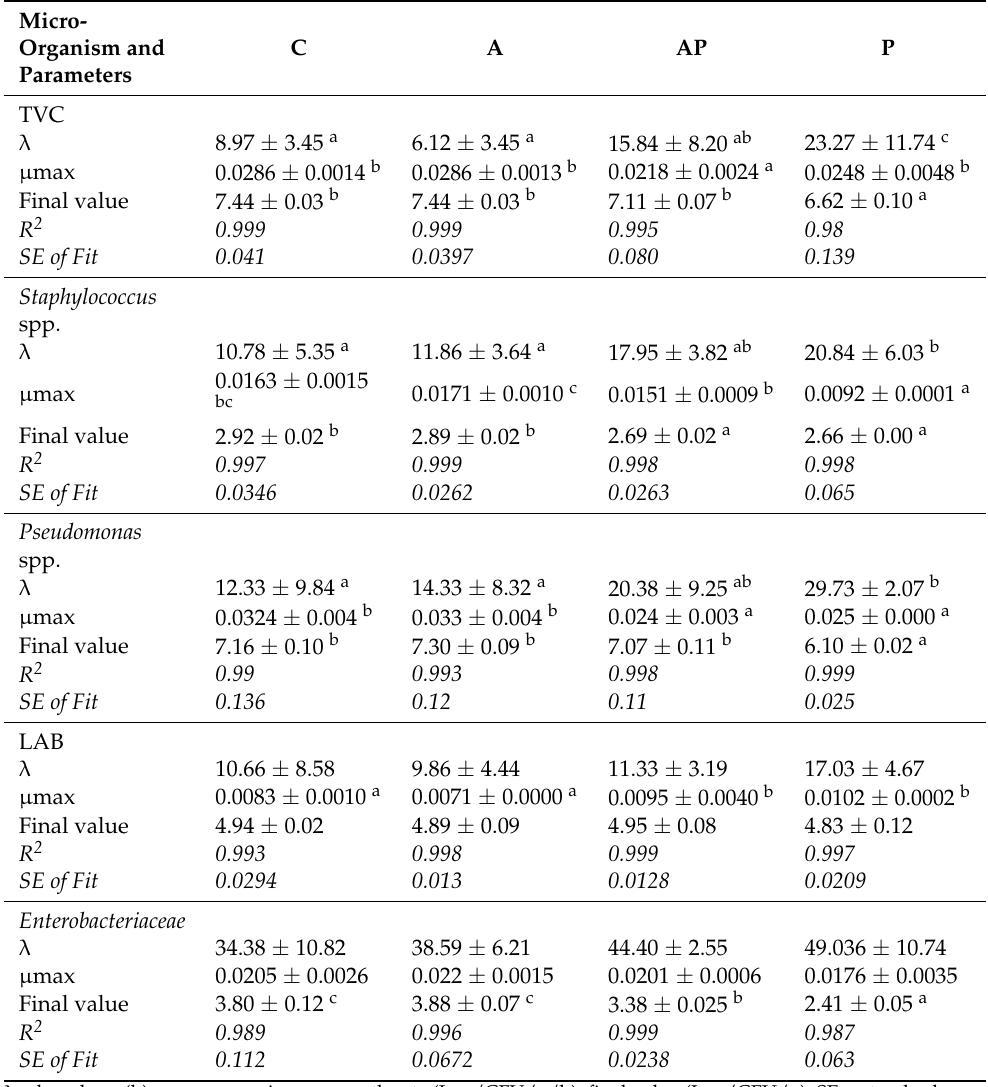
Table 4. Output parameters estimated by the DMFit program for each microbial population in the four formulations of beef